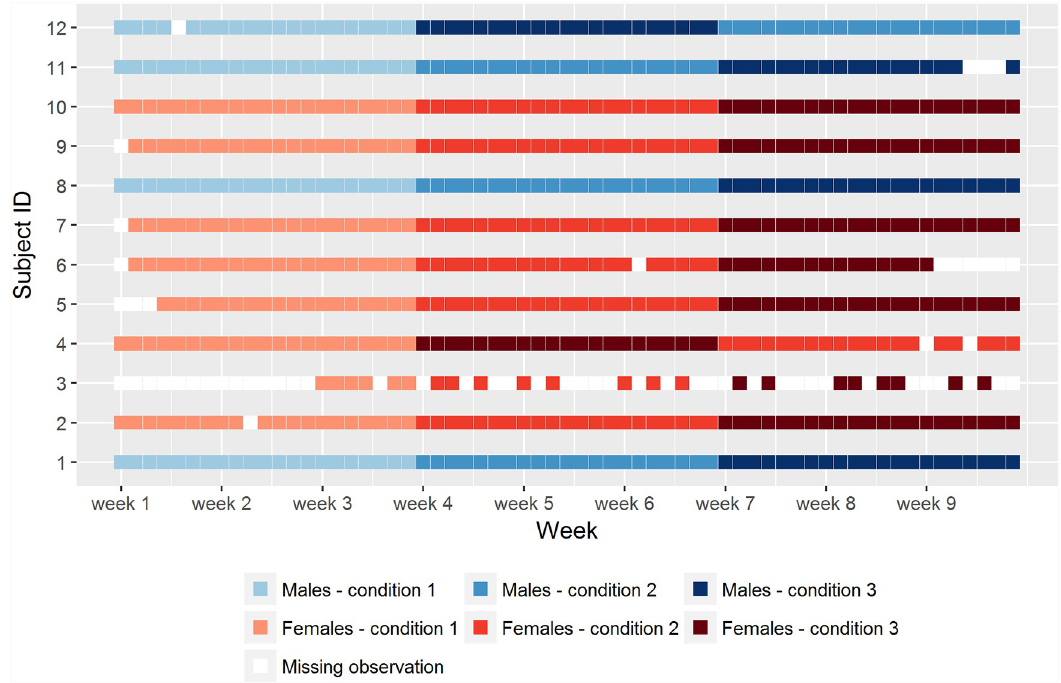
Fig 4. The course of each individual self-measurement trial in the empirical example data set, the conditions are: Condition 1 = control period; condition 2 = less food intake; condition 3 = increased physical activity.